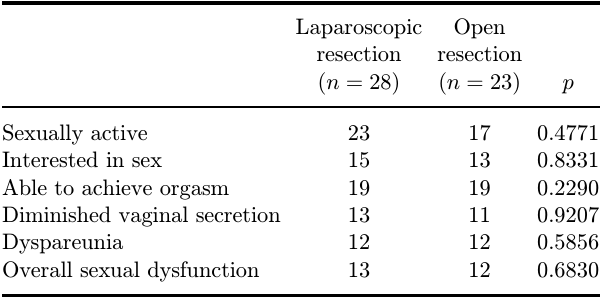
Table 6. Sexual function of female patients